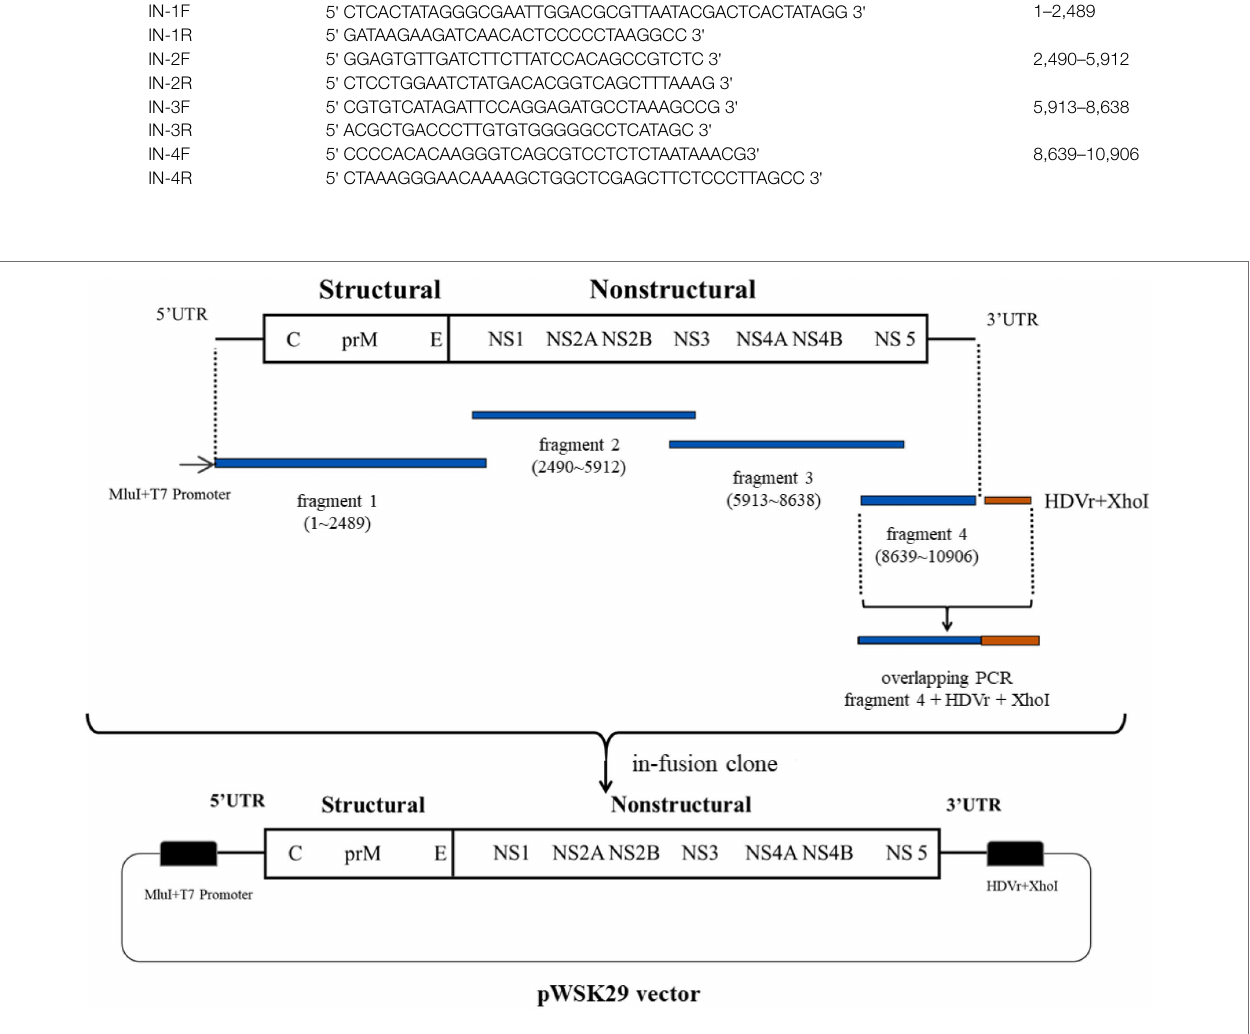
FIGURE 1 | Infectious clone construction procedure for ZIKV ZKC2 strain. Four fragments of PCR product containing a T7 promoter, the whole ZIKV genome, and HDVr were used to clone into linearized plasmid pWSK29 using in-fusion